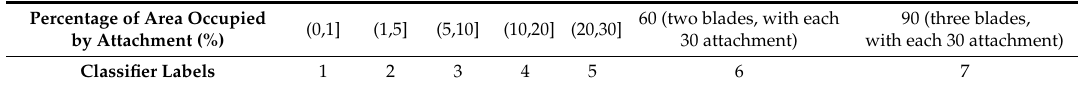
Table 1. Diagnostic category label.